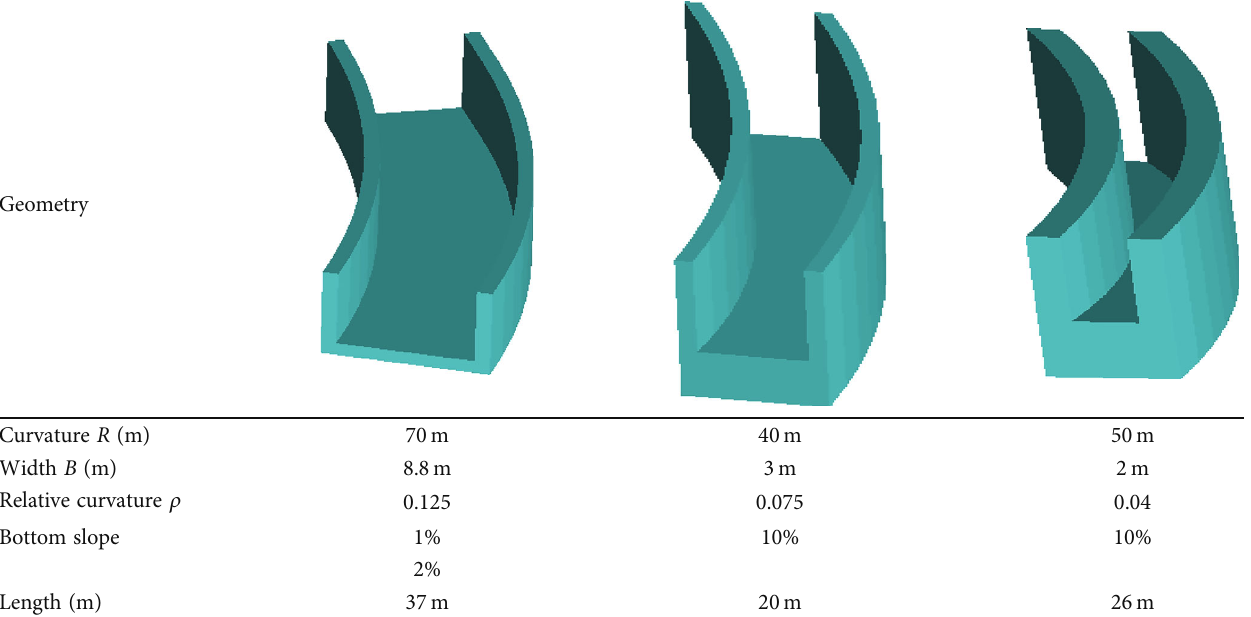
Table 1: Curved channels tested by CFD and theoretical